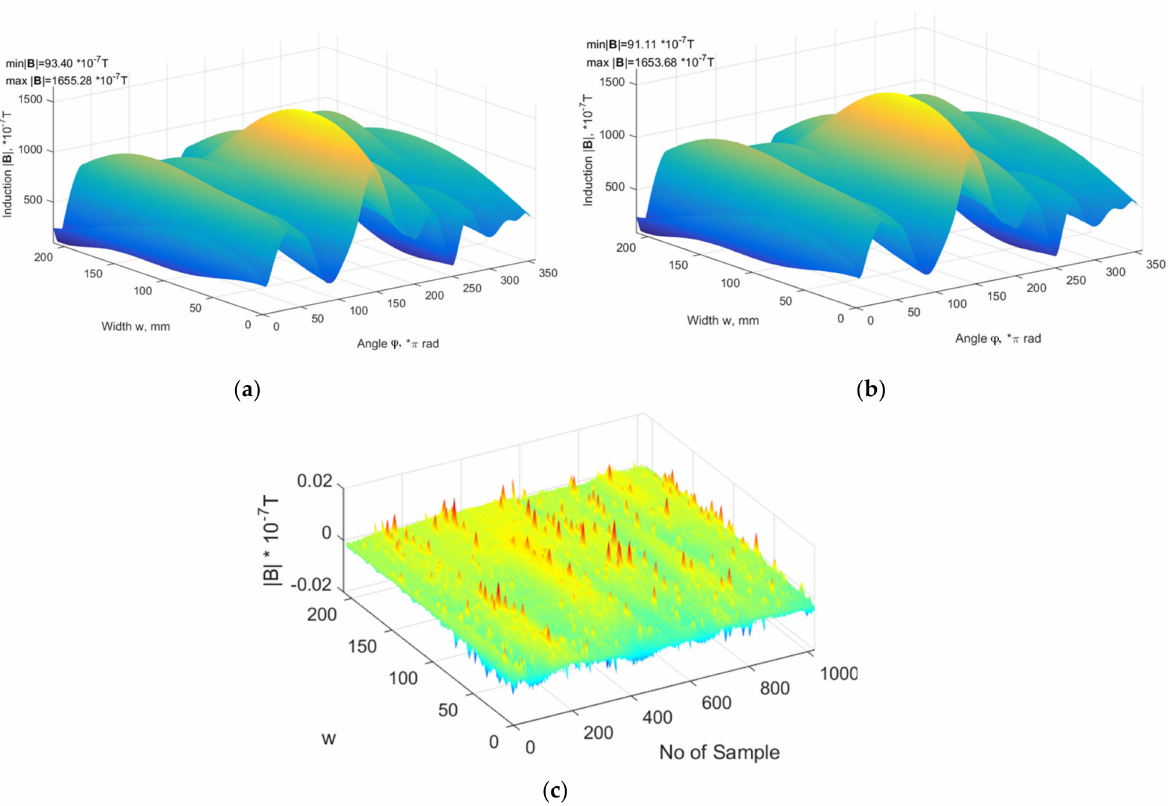
Figure 8. Magnetic profiles measured one after another in the same width of tread equal to 100 mm for R16/205/55 T tire ( a )and ( b ), and differences between first and following profiles ( c